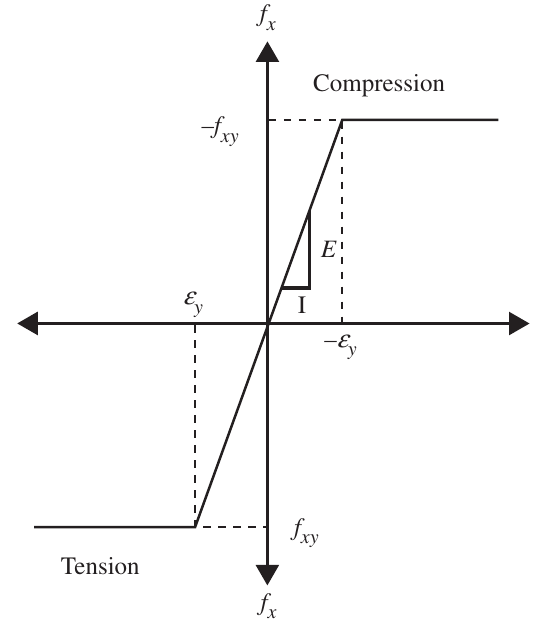
Fig. 1. Stress-strain curve for steel